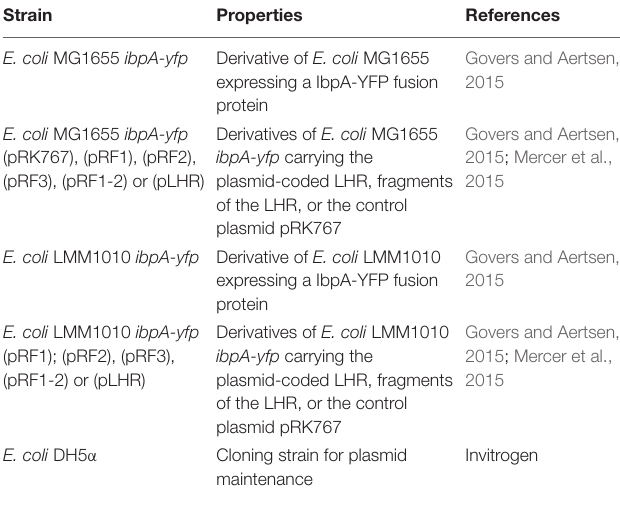
TABLE 1 | Strains and plasmids used in this